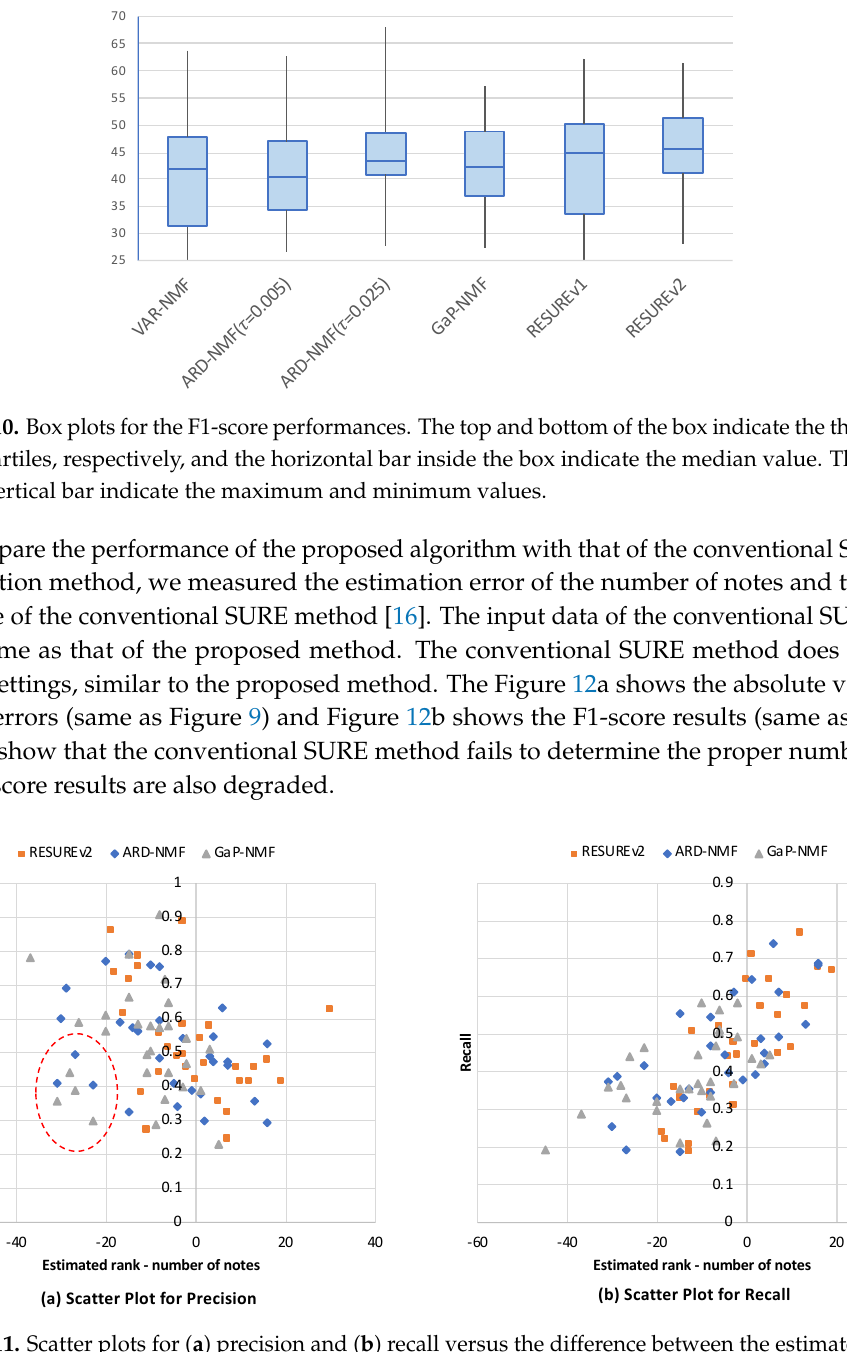
Figure 11. Scatter plots for ( a ) precision and ( b ) recall versus the difference between the estimated rank and number of notes (estimated rank number of